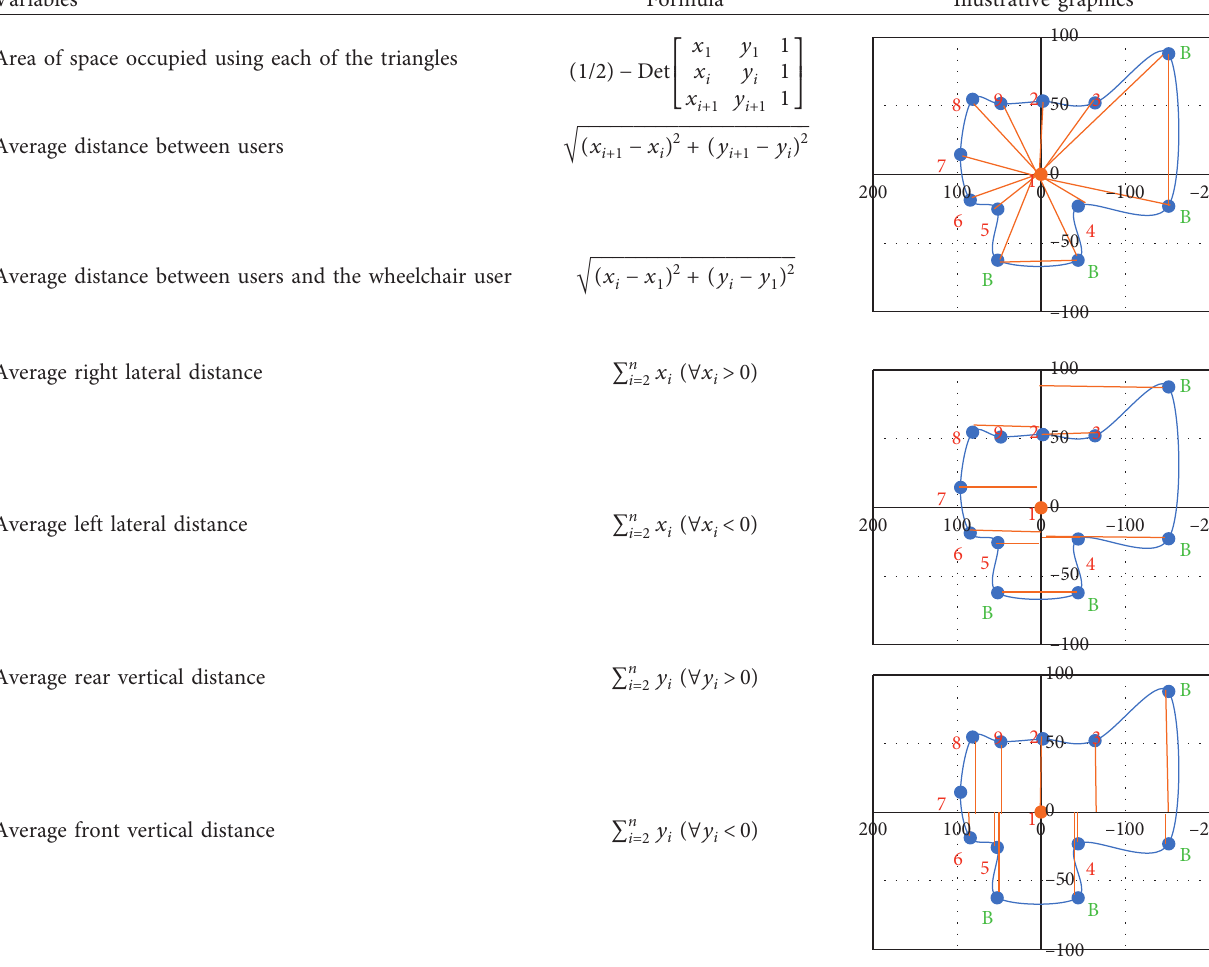
Table 2: Variables of the space occupied in the HDL